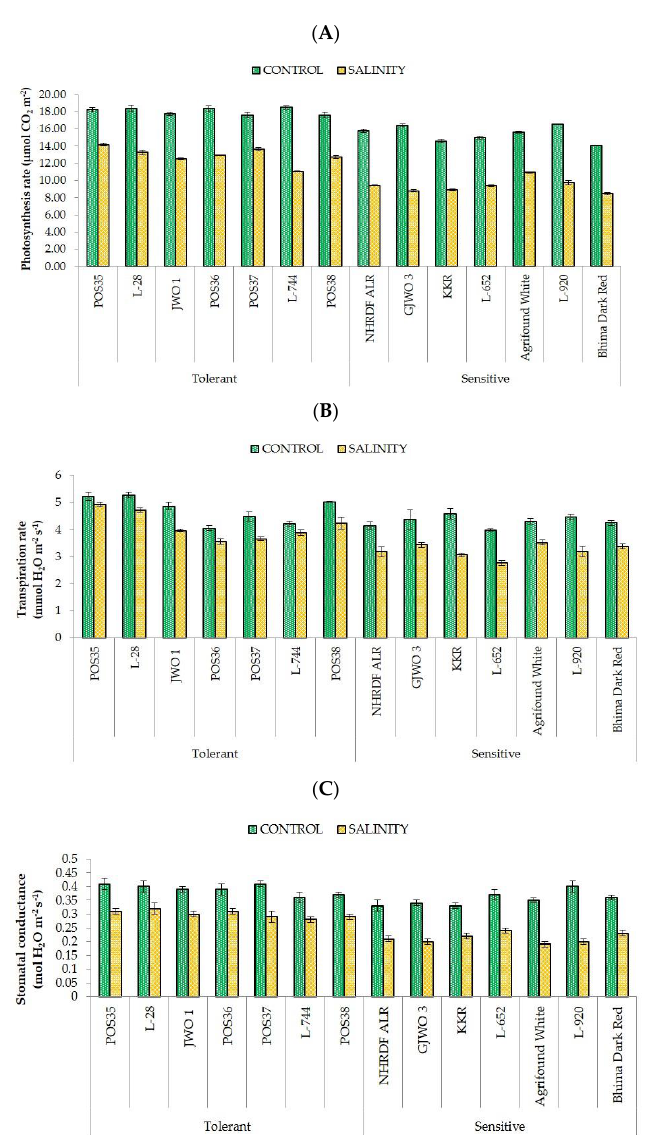
Figure 2. Alteration in gas exchange traits [Photosynthetic rate, ( A ); Transpiration rate, ( B ); and Stomatal conductance ( C )] of onion accessions under control and saline environments.